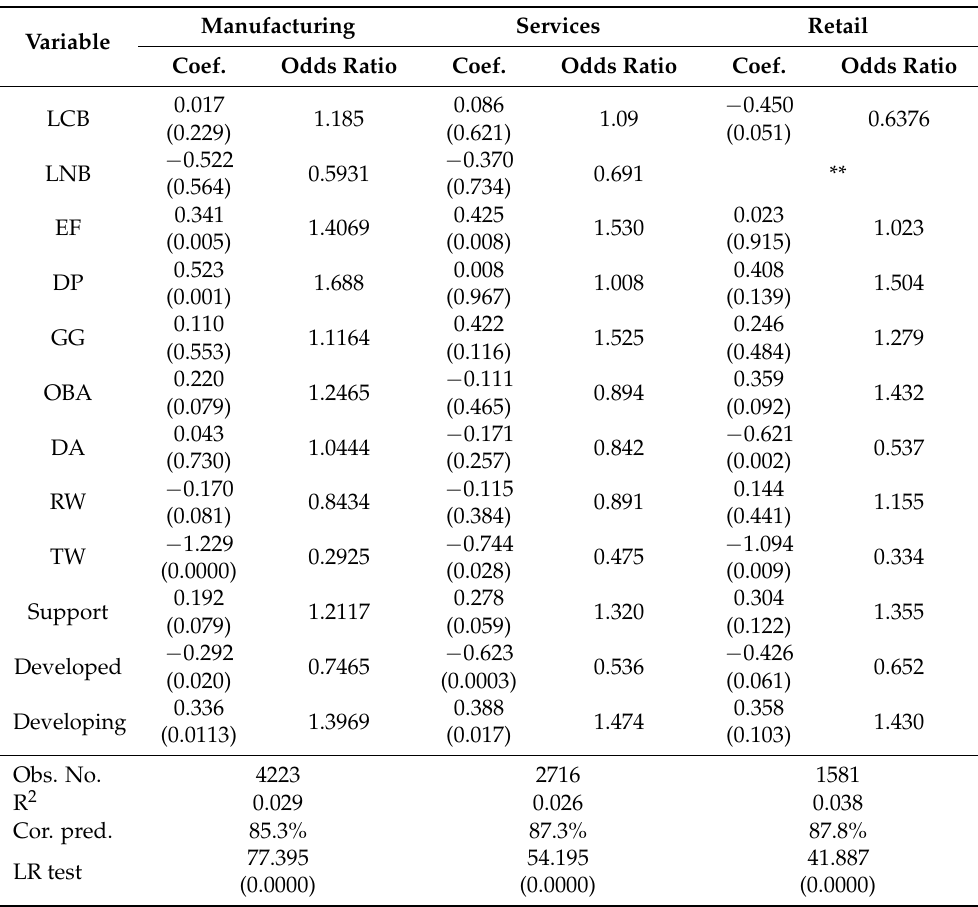
Table 7. Logit binary model’s estimation results *—demand decrease.